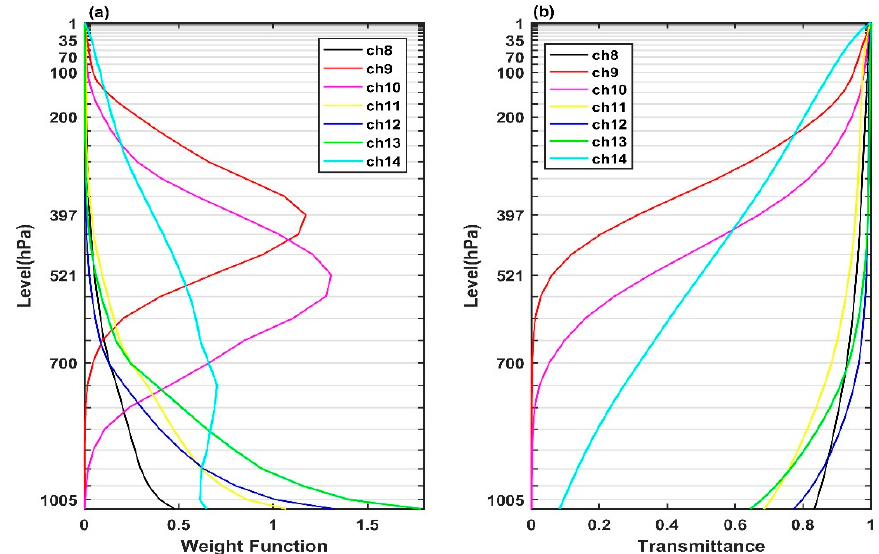
Figure 1. FY-4A AGRI infrared channels 8-14 ( a ) weighting function and ( b ) transmittance, calculated using RTTOV with the U.S. standard atmospheric profile as the input. Channel number is displayed in the legend.